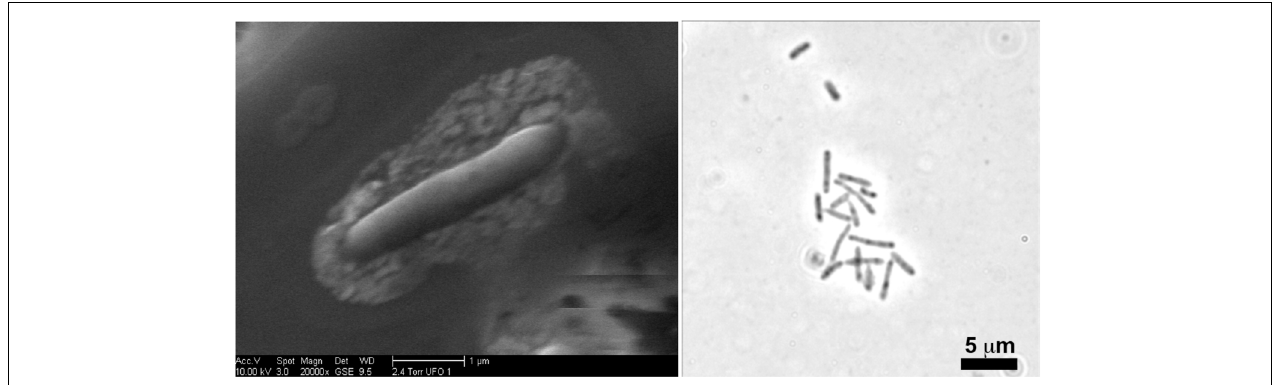
FIGURE 1 | Left Panel: Scanning electron micrographs revealing extracellular materials surrounding a cell of “ P. lilae ” UFO1. Right Panel: Light micrograph of a culture of “ P. lilae ” UFO1 with apparent spore-like structures, the dark areas within cells, usually located at the cell terminus. Note the extracellular materials associated with the cell.